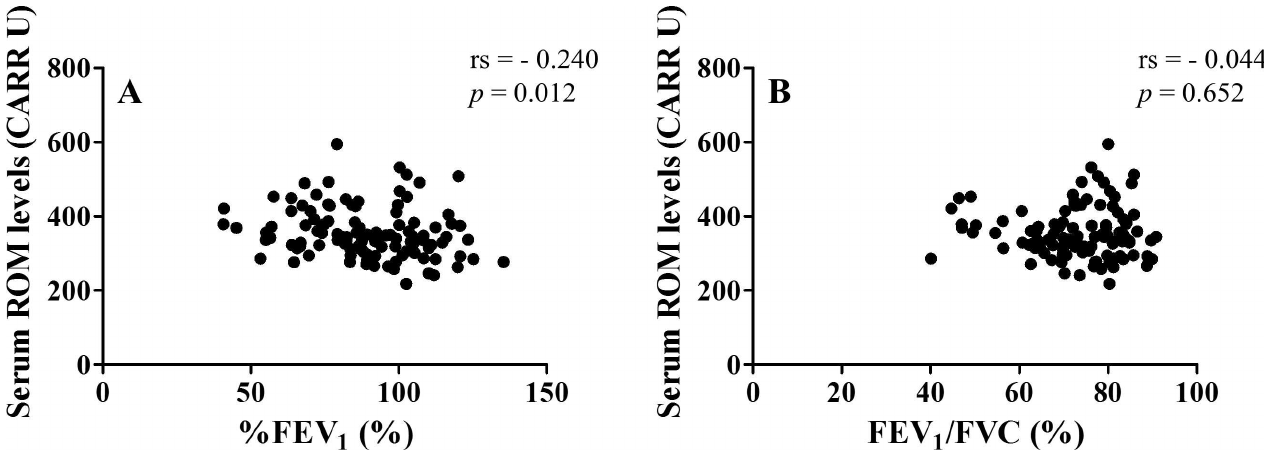
Fig 2. Correlation between serum reactive oxygen metabolite (ROM) levels and pulmonary function parameters. (A) Serum ROM levels and %FEV 1 . (B) Serum ROM levels and FEV 1 /FVC. %FEV 1 , percent predicted forced expiratory volume in 1 second; FVC, forced vital capacity.